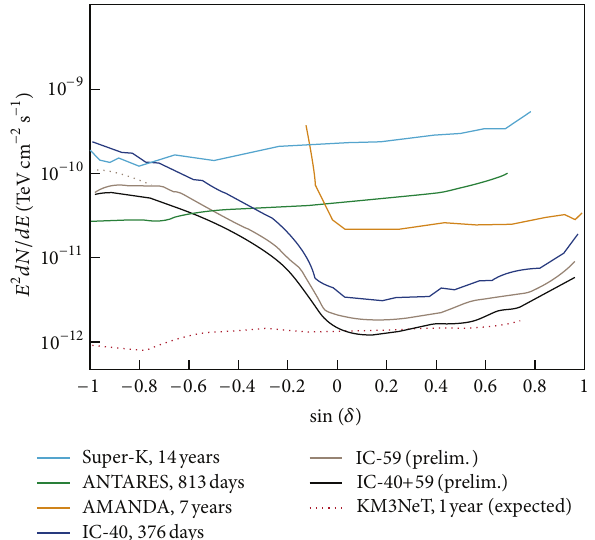
Figure 11: Sensitivities of running and future neutrino detectors to pointsourcefluxeswith 𝐸 −2 spectrumasfunctionsofthedeclination angle 𝛿 . Figure from [82].